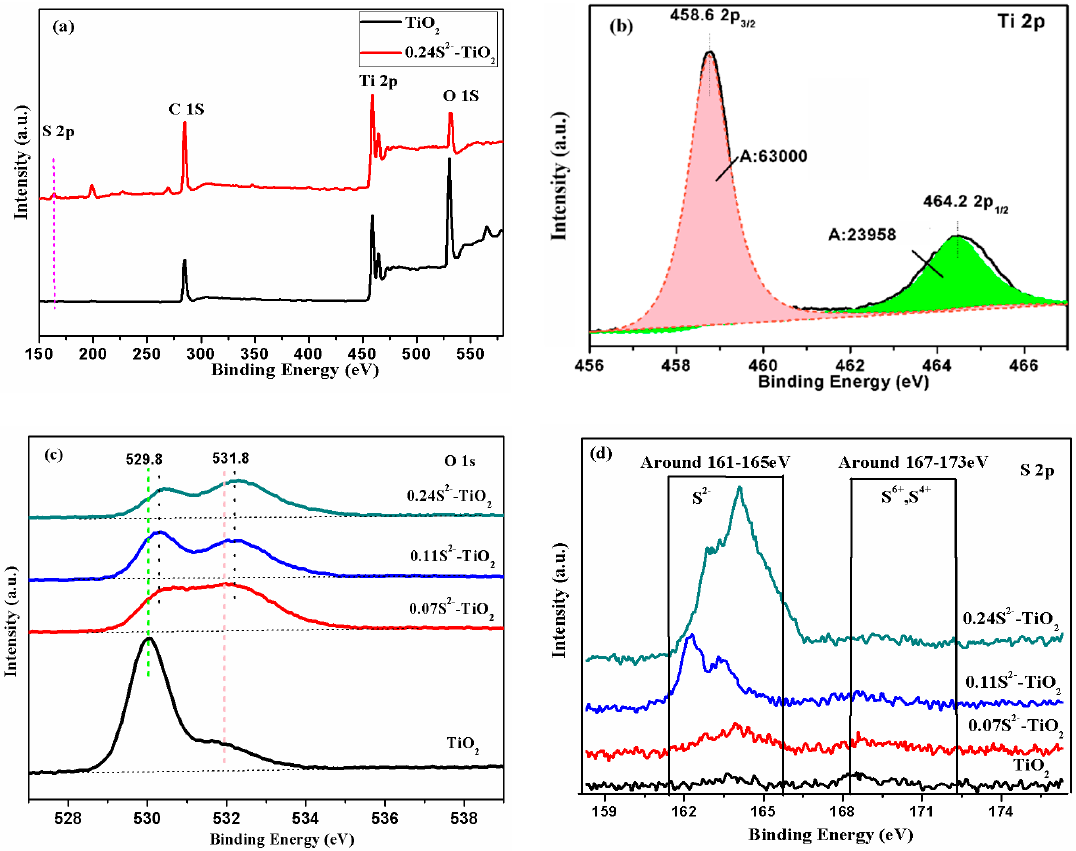
Figure 5. X-ray photoelectron spectroscopy (XPS) spectra of the as-prepared samples: ( a ) survey, ( b ) Ti2p, ( c ) O1s, ( d ) S2p.